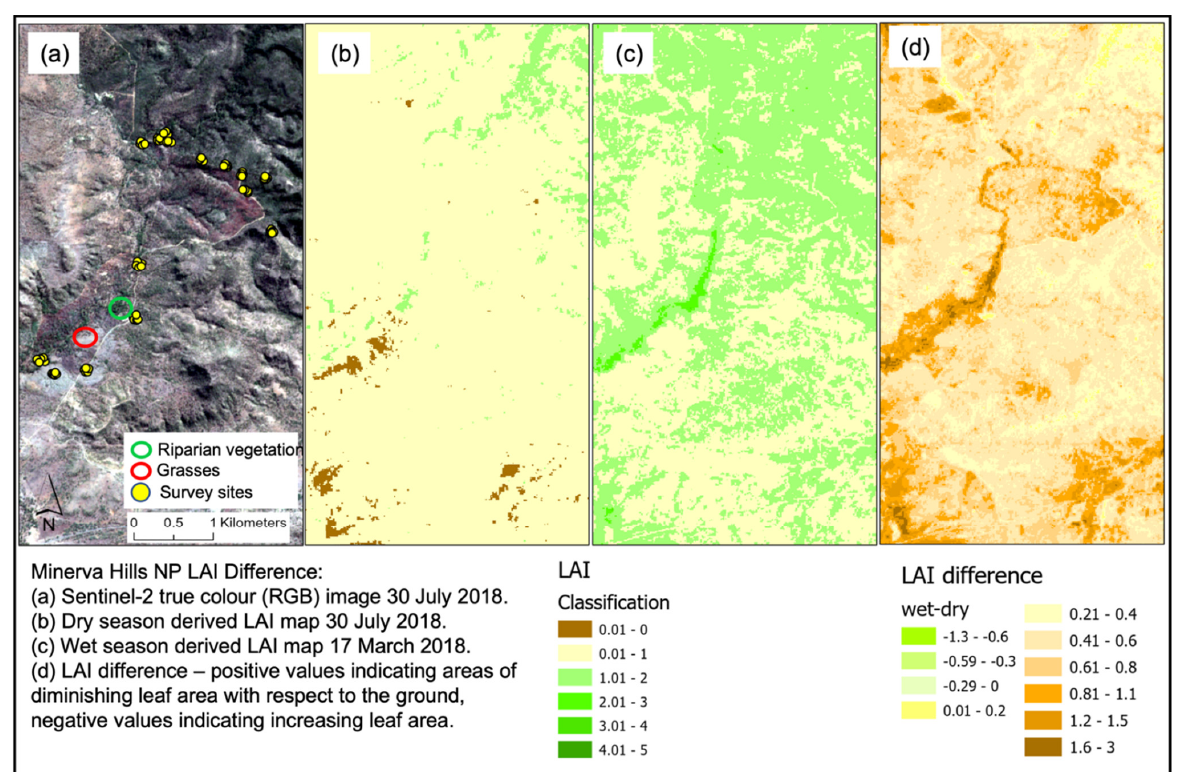
Figure A8. Minerva Hills NP LAI Difference.